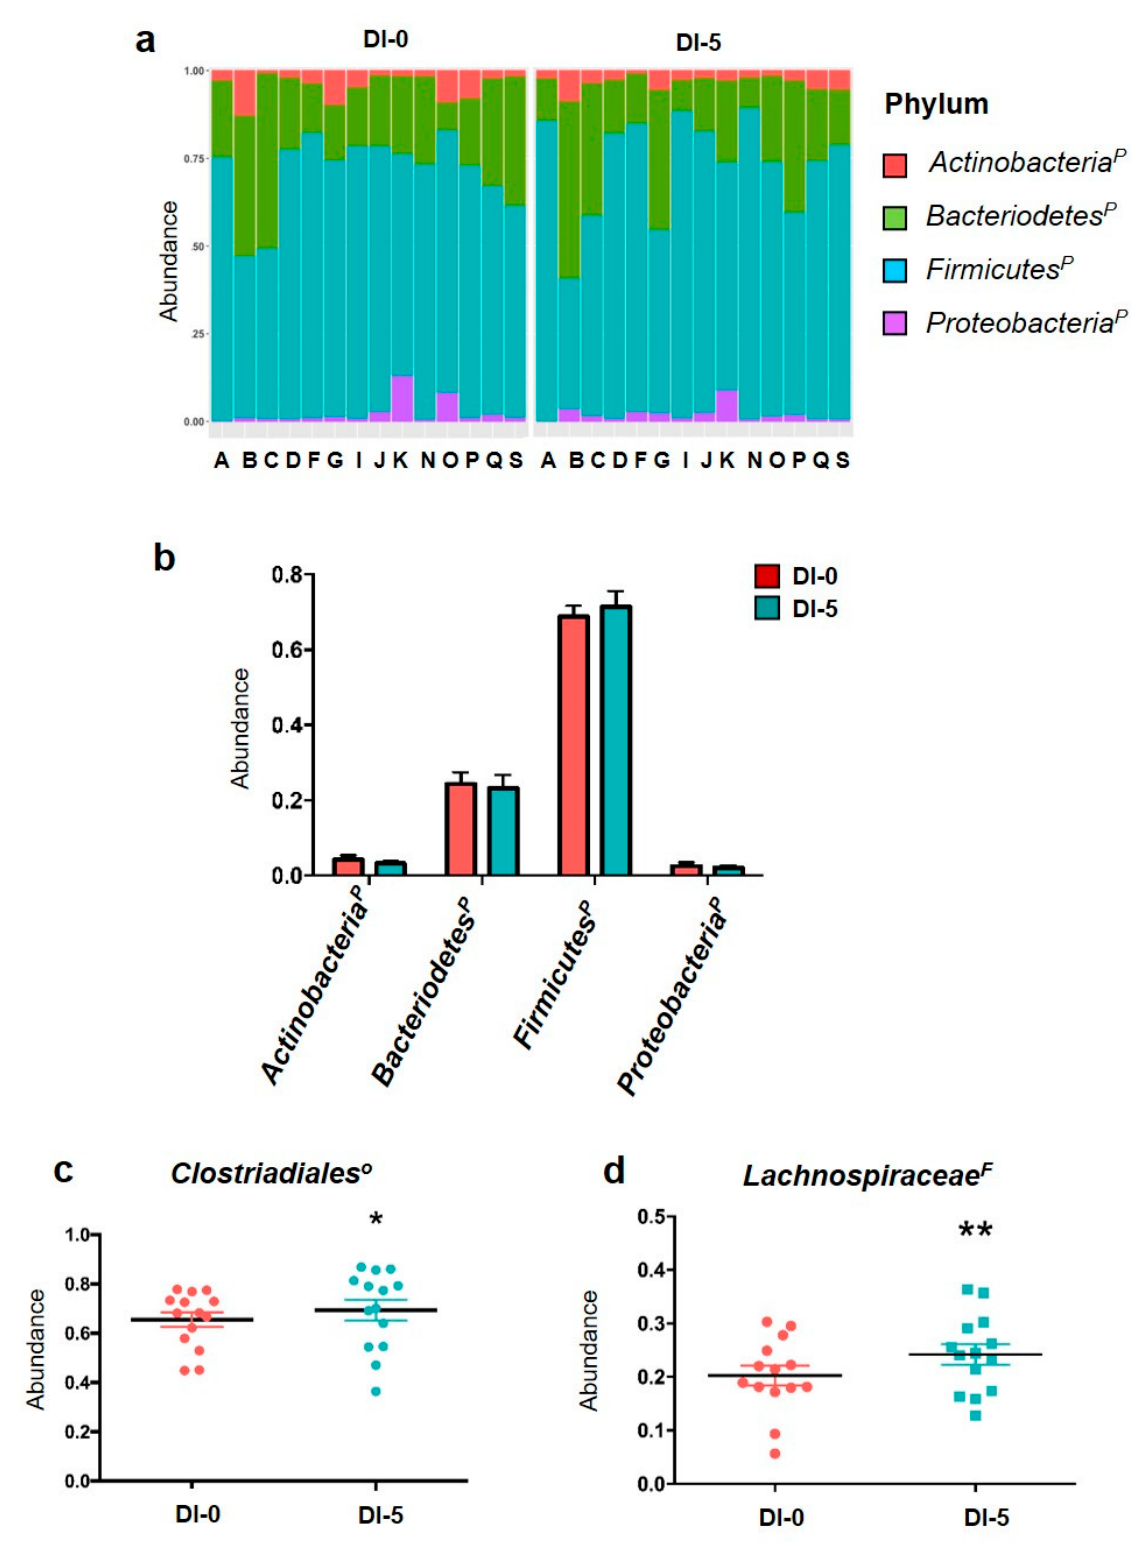
Figure 4. Abundance of phyla by 16S rRNA sequencing. ( a ) Individual abundance of the four main gut microbiota phyla in humans before (DI-0) and after 5 days of dry immersion (DI-5) in healthy men ( n = 14). ( b ) Comparison ( t -test) of the abundance of these four phyla at DI-0 and DI5 in healthy men ( n = 14). ( c ) Clostridiales order abundance is significantly increased by DI. ( d) Lachnospiraceae family abundance is increased by 5 days of dry immersion. p = Phylum; O = Order; F = Family; * p < 0.05; ** p < 0.01 (paired t -test). Data are mean ±